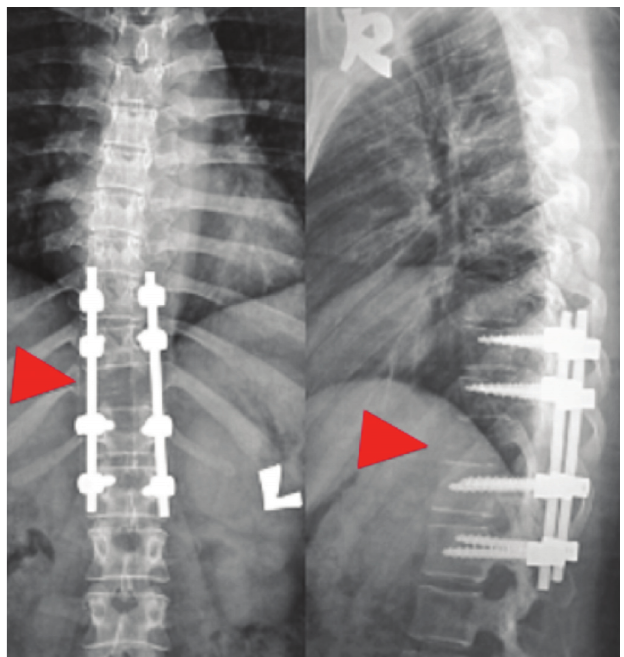
Fig. 3: Spinal radiograph eight months after surgery demonstrates T11 vertebrae body radiolucency (arrowhead). Implants are intact, with no other vertebrae